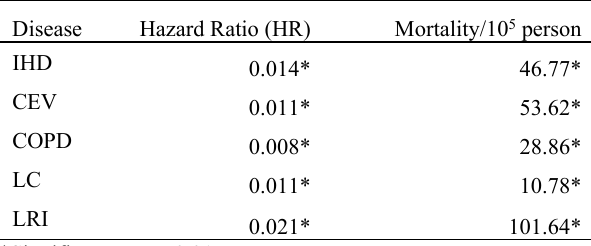
Table 2 . Trends in hazard ratio and mortality associated with PM 2.5 .